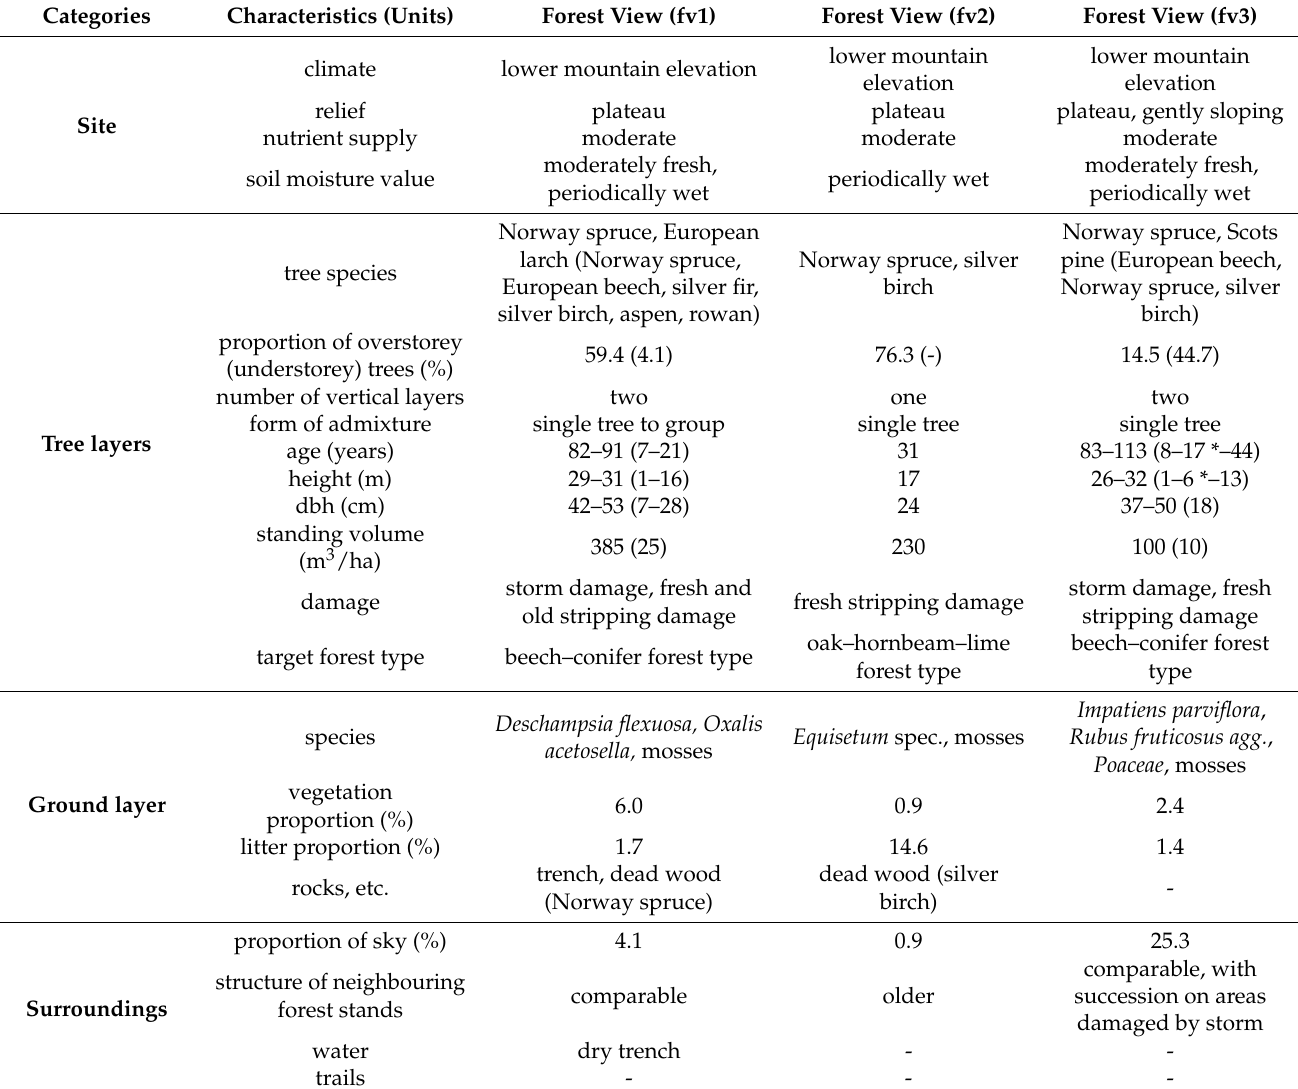
Table 1. Overview of stand characteristics and forest inventory data relevant for visual aesthetics, silviculture and forest management (* specific age and height of underplanted European